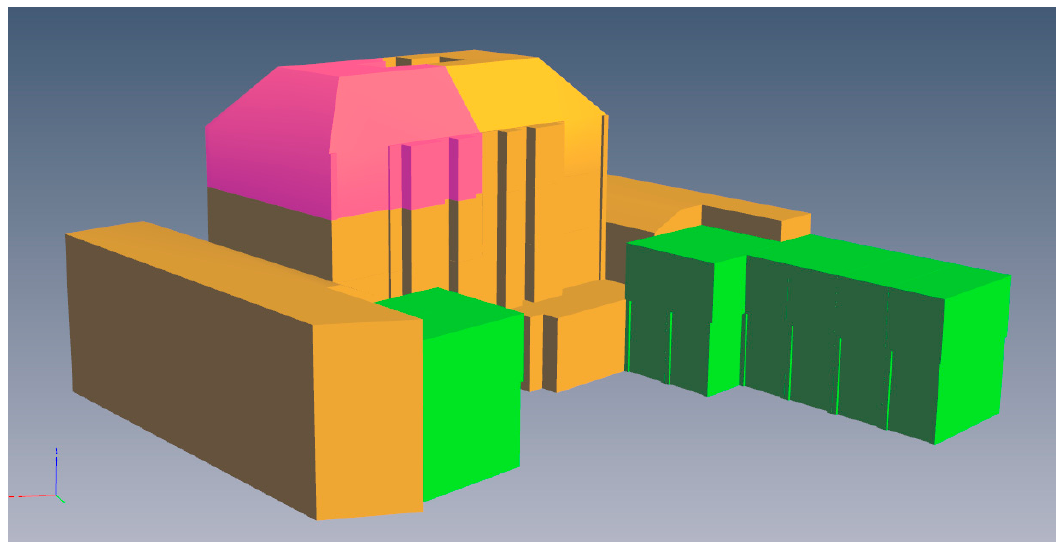
Figure 7. A perspective view of a unit title development, being a set of spatial objects which represent the 3D extents of parcels of rights, restrictions and responsibilities associated with a multilevel apartment complex (a single 3D parcel is highlighted in magenta). The digital model is based on the paper-based 3D cadastral survey dataset discussed in Section 2.8 above.